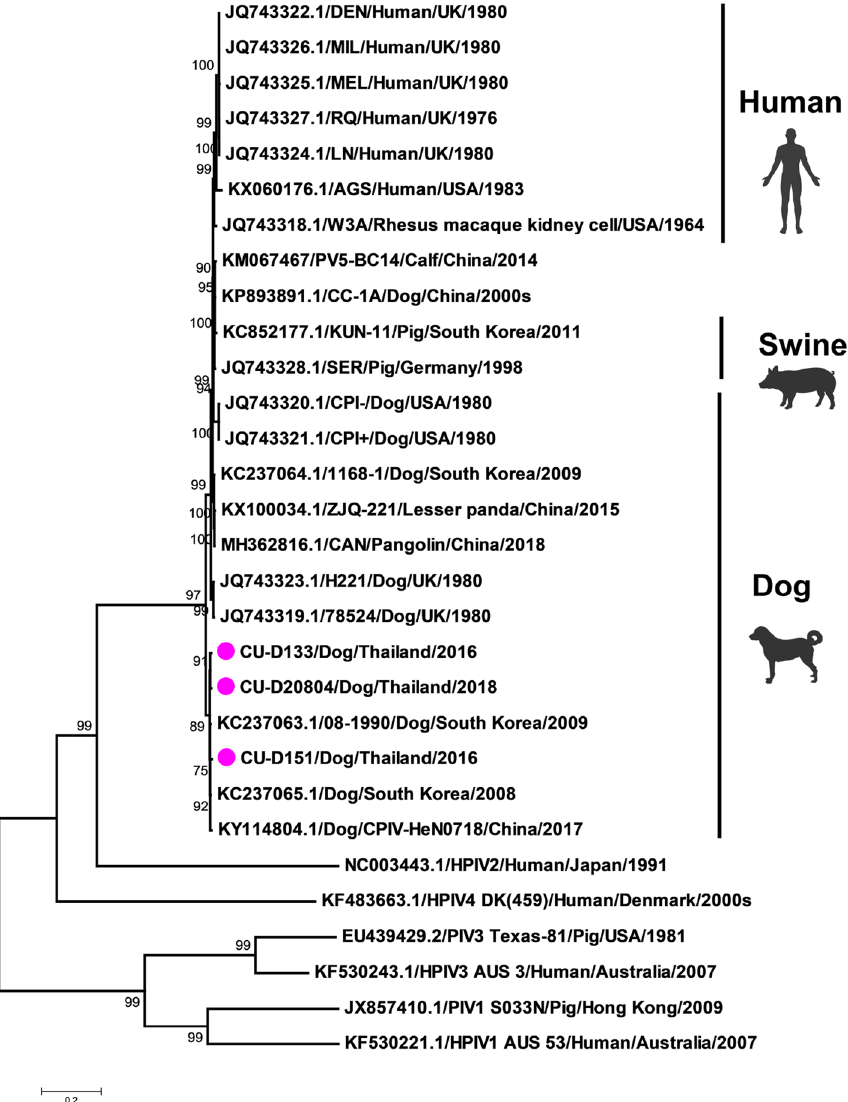
Figure 1. Phylogenic tree of the whole genome of Thai CPIV-5 and reference PIV1-5. Pink circles indicate Thai CPIV-5 in this study. The phylogenetic tree was constructed by using MEGA v.7.0 (Tempe, AZ, USA) with the neighbor-joining method with the Kimura 2-parameter with 1000 bootstrap replication 52 . The drawing was created by professional science figure service